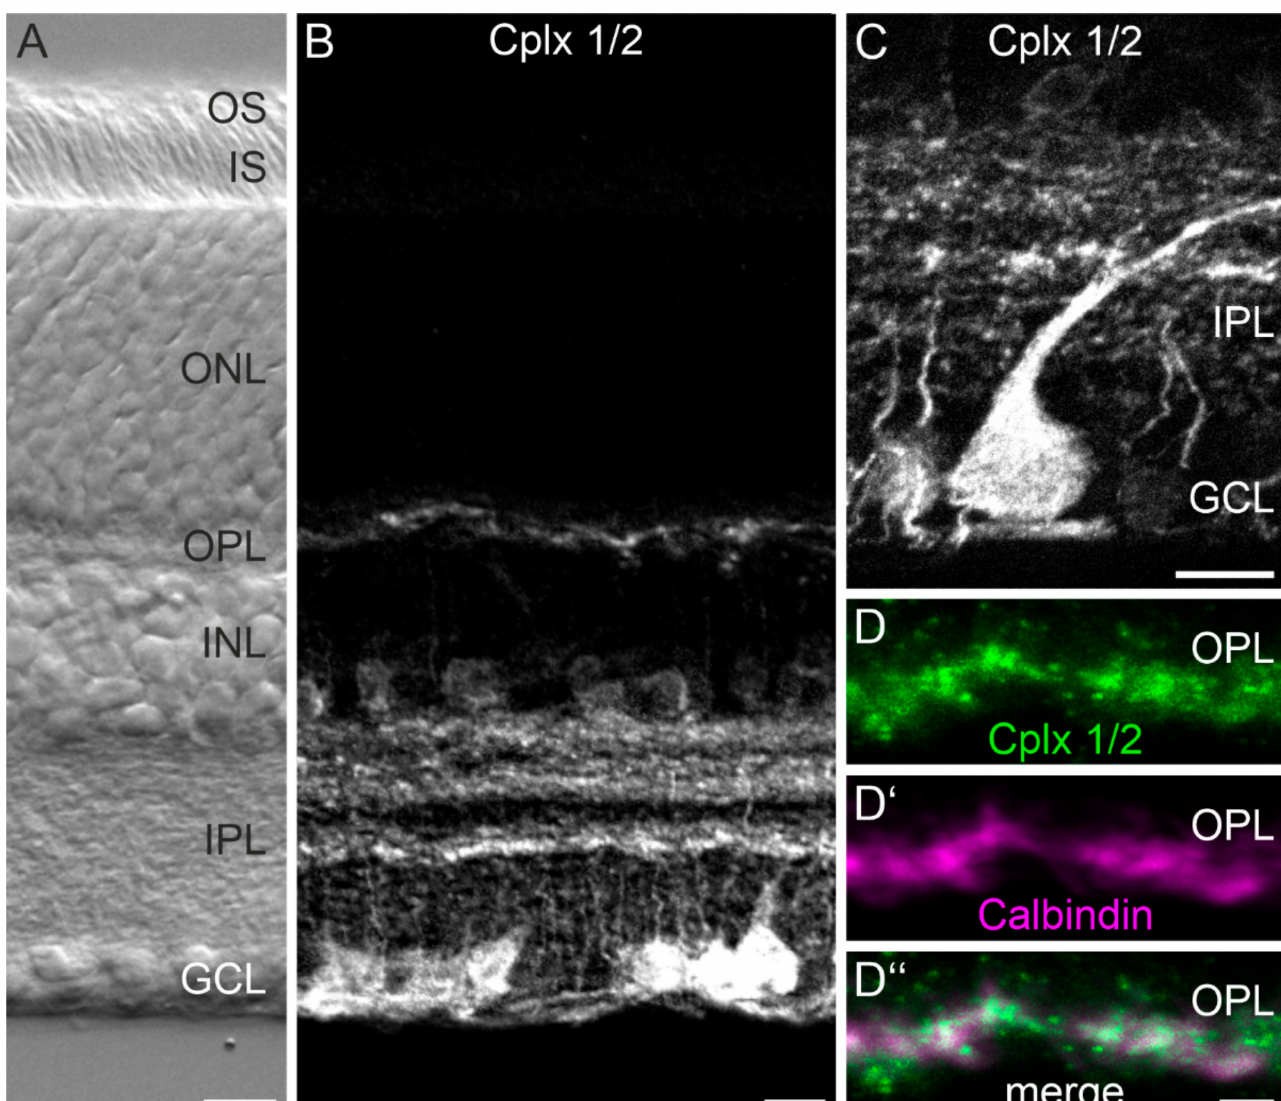
Figure 1. Distribution of Cplx 1/2 in mouse retina. ( A ) Nomarski micrograph of a vertical vibratome section through a mouse retina showing the different retinal layers. ( B , C ) Fluorescence micrographs of vertical vibratome sections through mouse retinae stained with an anti-Cplx 1/2 antibody. A higher-power view of Cplx 1/2 staining in the inner plexiform layer (IPL) and ganglion cell layer (GCL) is shown in ( C ). ( D – D (cid:48)(cid:48) ) Fluorescence micrographs showing a part of the outer plexiform layer (OPL) double labeled for Cplx 1/2 and calbindin to mark the horizontal cells. OS, outer segments; IS, inner segments; ONL, outer nuclear layer; INL, inner nuclear layer. Scale bar = 10 µ m in ( A – C ) and 2 µ m in ( D (cid:48)(cid:48) ) for ( D – D (cid:48)(cid:48)